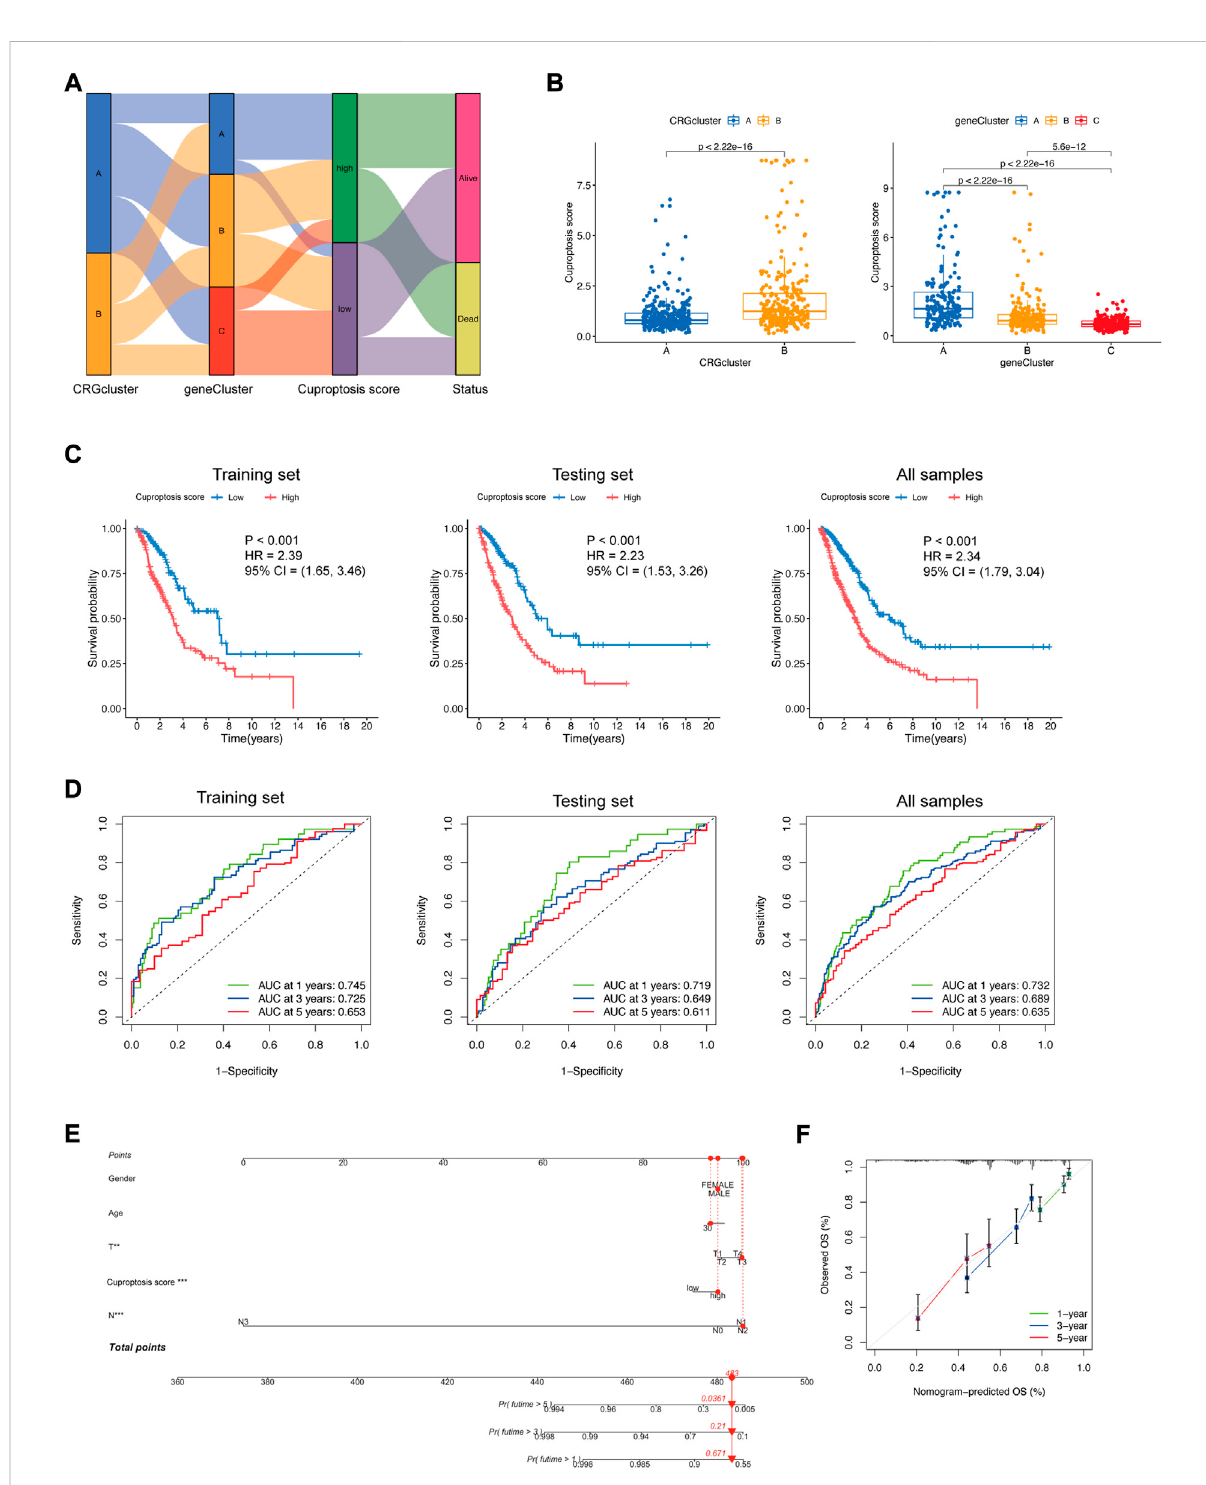
FIGURE 6 Construction of the cuproptosis signature. (A) Sankey diagram displaying the relationships among CRG-related clusters, DEG-related clusters, the cuproptosis score, and the status of LUAD patients. (B) Cuproptosis score differences in CRG-related clusters and DEG-related clusters (Wilcoxon test). (C) Kaplan − Meier plots of the cuproptosis signature and overall survival probability in the training set, testing set, and all samples. (D) ROCs for one-year, three-year, and fi ve-year survival prediction. (E) Nomogram model in LUAD patients. The cuproptosis score is an independent prognostic factor. (F) Calibrationcurvefortheoverallsurvival(OS)ofthenomogram model. Adasheddiagonal linerepresentstheideal